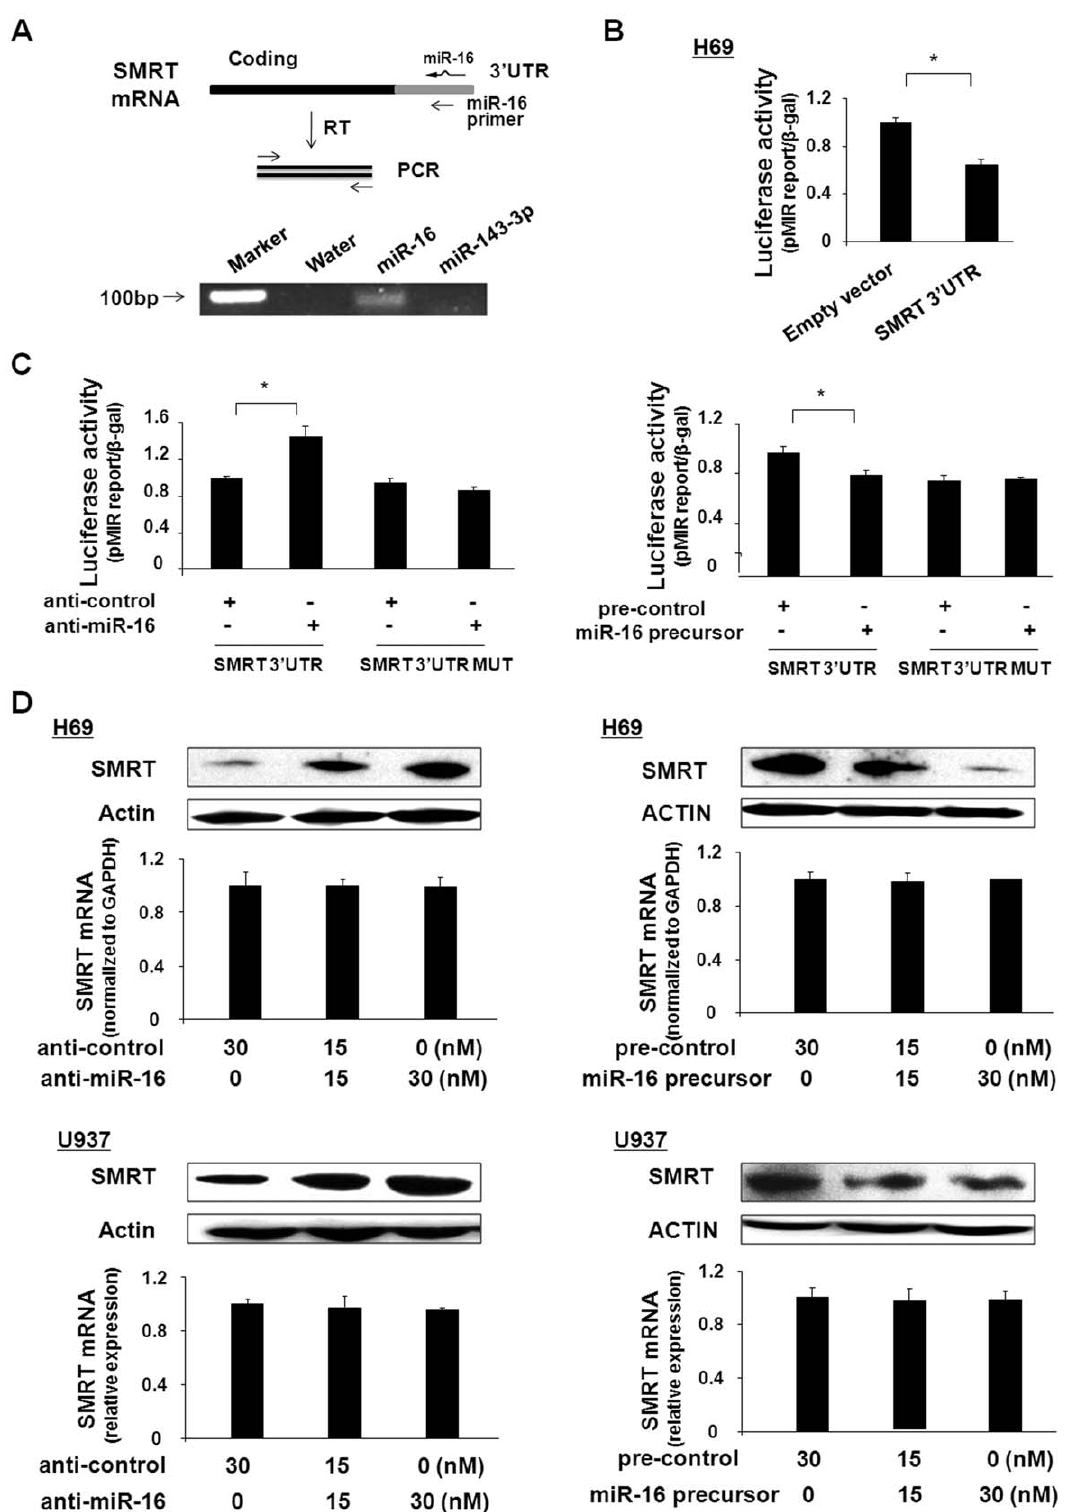
Figure 5. miR-16 targets the SMRT 3 9 UTR, resulting in translational suppression of SMRT. (A) Binding of SMRT 3 9 UTR by miR-16 as assessed by a modified RT-PCR approach. The schematic shows the approach using a miR-16 oligonucleotide to prime first-strand synthesis from SMRT mRNA. Following extraction of total RNA from H69 cells, RT was conducted with either a DNA oligonucleotide corresponding to miR-143-3p (negative control) or miR-16, or no primer (negative control), as indicated. Subsequently, PCR was performed with primers specific to SMRT. A 100-bp DNA marker was loaded as a reference. (B) and (C) Targeting of the SMRT 3 9 UTR by miR-16 results in translational suppression of SMRT in H69 cells. Cells were transfected with the pMIR-REPORT luciferase construct containing the miR-16 binding site in the SMRT 3 9 UTR, and treated with the anti-